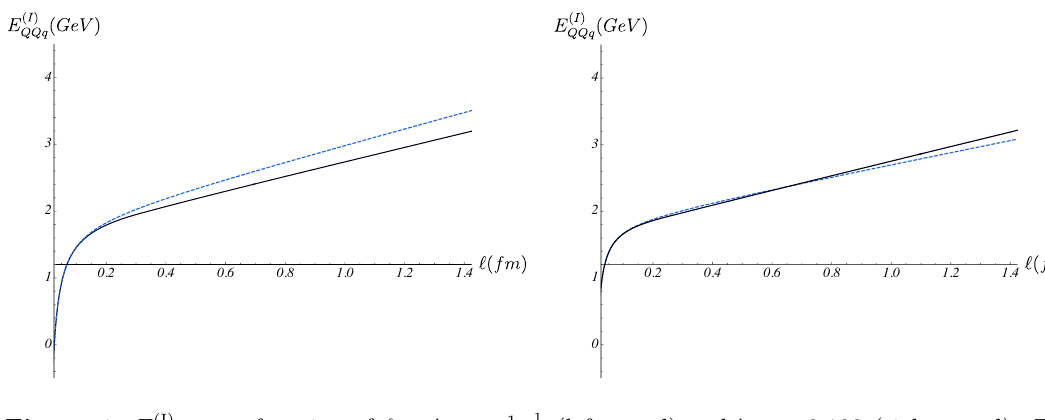
Figure 4 . E (I) as a function of ‘ at k = − 1 e 1 4 (left panel) and k = − 0 . 102 (right panel). The QQq 4 dashed curves represent the small ‘ behavior, as obtained from eq.